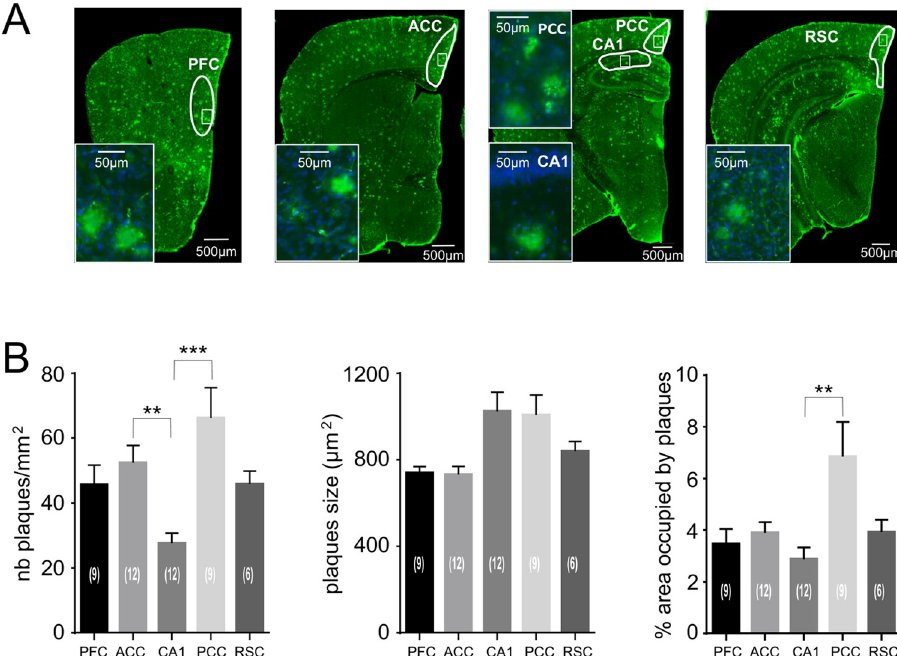
Fig 6. β -amyloid plaque pathology in coronal slices of APPxPS1 mice brains. A, Anti-A β 1–42 immunoreactivity (6E10 + poly18058 antibodies) in coronal slices of APP/PS1 mice brains. Regions of interest are drawn in white. The inserts show higher magnification of regions delimitated by small white rectangles. Cell nuclei counterstained with Dapi (in blue). Notice that Dapi staining shows that cell nuclei are surrounding the plaques. B, Bar graphs illustrating the statistical analyses of the number of plaques (left), plaque size (middle) and area occupied by plaques (right) in the regions of interest (PFC, ACC, CA1, PCC, RSC). Notice more numerous and larger plaques in PCC versus other regions. Dunn’s test of multiple comparisons were used for statistical analyzes, �� p < 0.01, ��� p <